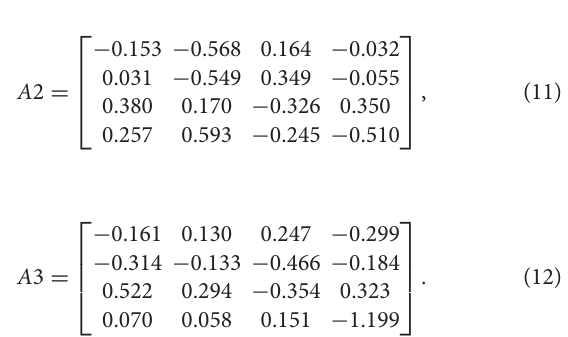
FIGURE 1 | Procedures for state-dependent effective connectivity analysis. A time series of the brain activity was obtained using a group independent component analysis (gICA) of the resting-state functional MRI (rsfMRI). A spectral DCM (spDCM) was estimated for each window separately for each participant. Parametric empirical Bayesian analysis (PEB) with temporal regressors of states can estimate the state-dependent effective connectivity in each individual. For the group-level analysis, the fixed effects model concatenates sets of windowed DCM parameters ( { A w ∈ W } s ) of all individuals into a set of DCM parameter series, which were then modeled with state labels using PEB. The random-effects model can be solved by applying PEB two times: one time for the windowed DCMs of each individual; and other time for the parameters of each individual, estimated using the first-level PEB to infer the group-level parameter sets. W:{1,2, …, number of windows}, N: number of